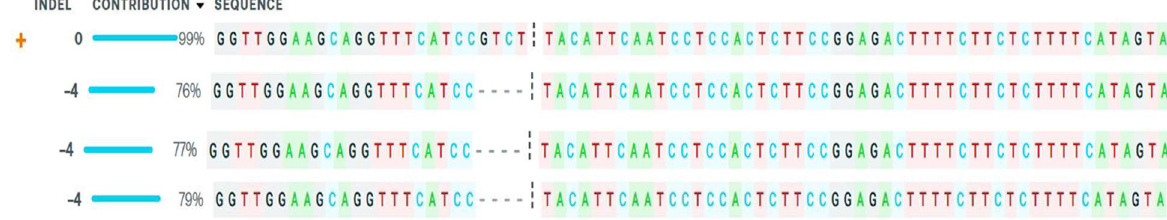
Figure 5. Illustration of ICE Analysis of RVE7 sgRNA1 (GTGGAGGATTGAATGTAAGACGG) RNP complex edited protoplast cells in chickpea. The respective protoplast samples were edited and sequenced with Sanger sequencing (Macrogen, Seoul, Korea) and further analyzed with the ICE (Synthego, Redwood City, CA, USA) online tool to deconvolute the pooled protoplast DNA. The contributions show the sequences inferred in the edited protoplast population and their relative proportions. The “+” sign is for the wild type sample. The target cut sites are denoted by black vertical dotted lines. The trace plots for the edited samples below show the cut site and protospacer adjacent motif (PAM) sequence labelled in the edited sample and control sample. The sgRNA 2 sequencing samples had low quality before the cut site and could not be analyzed using the ICE tool.